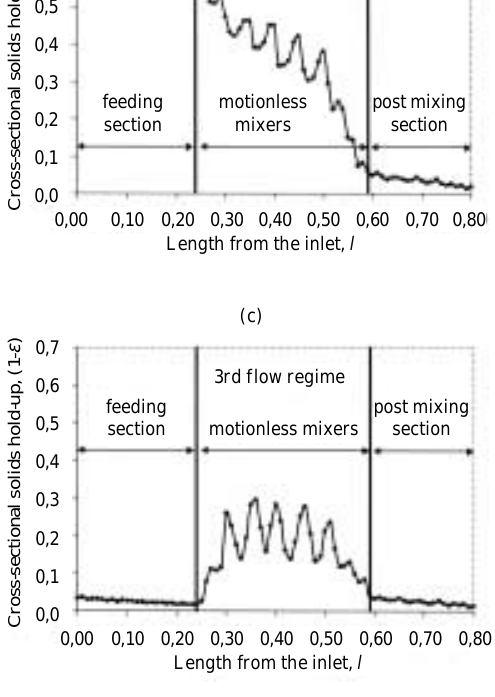
Fig. 6 Variation of the local cross-sectional solids volume frac- tions along the tube length in the three characteristic flow regimes ( a ) 1 st flow regime, ( b ) 2 nd flow regime, ( c ) 3 rd